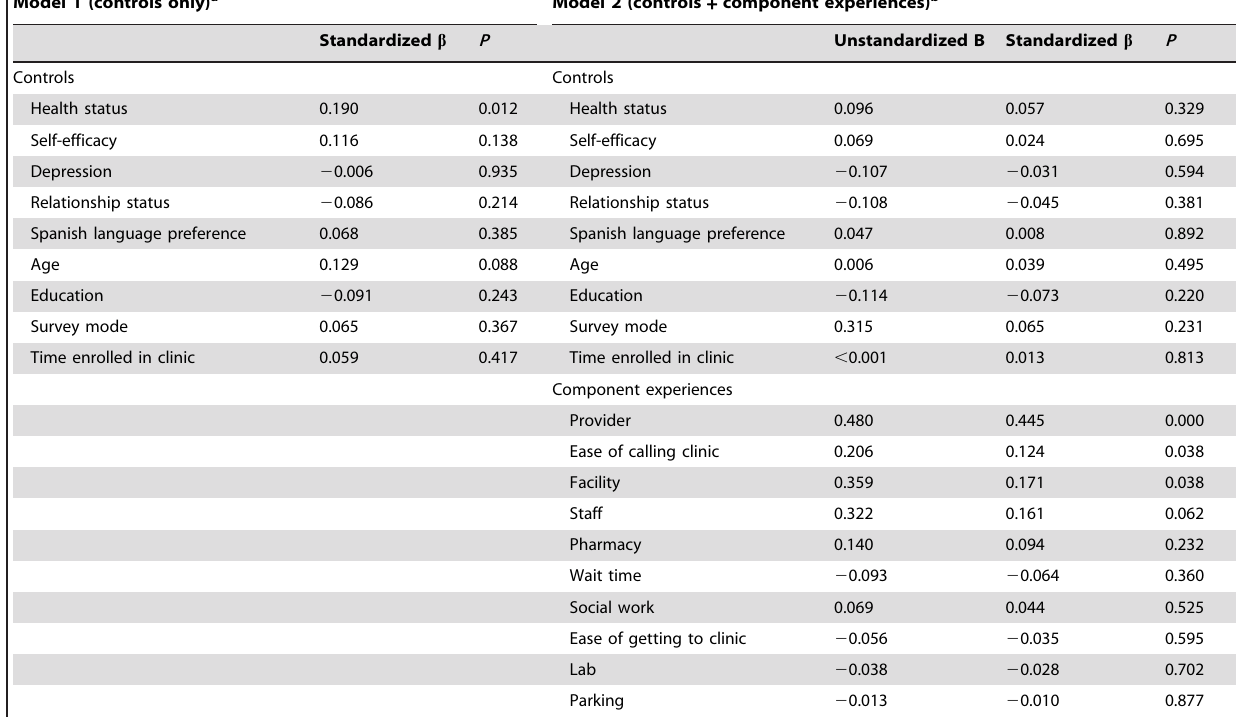
Table 4. Multiple regression of patients’ component experiences on overall